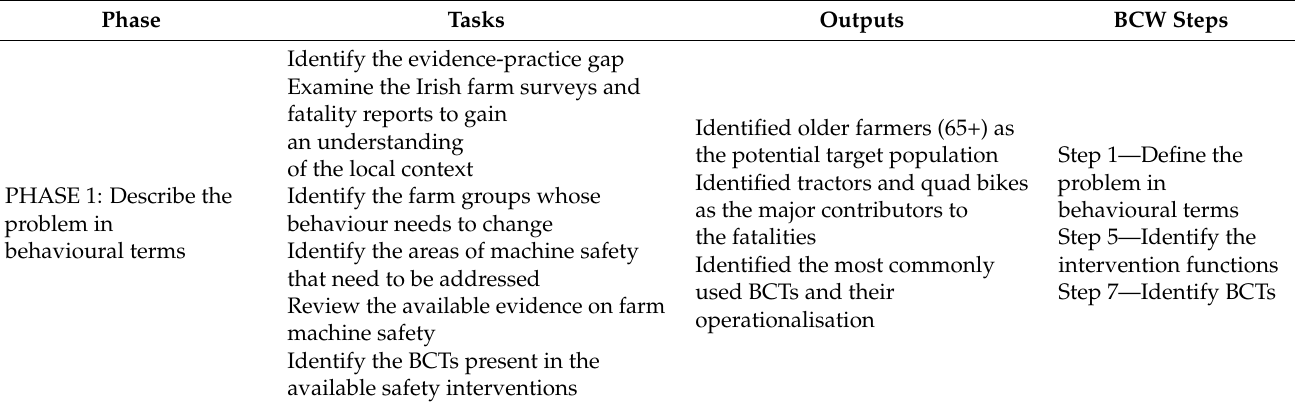
Table 1. Intervention development